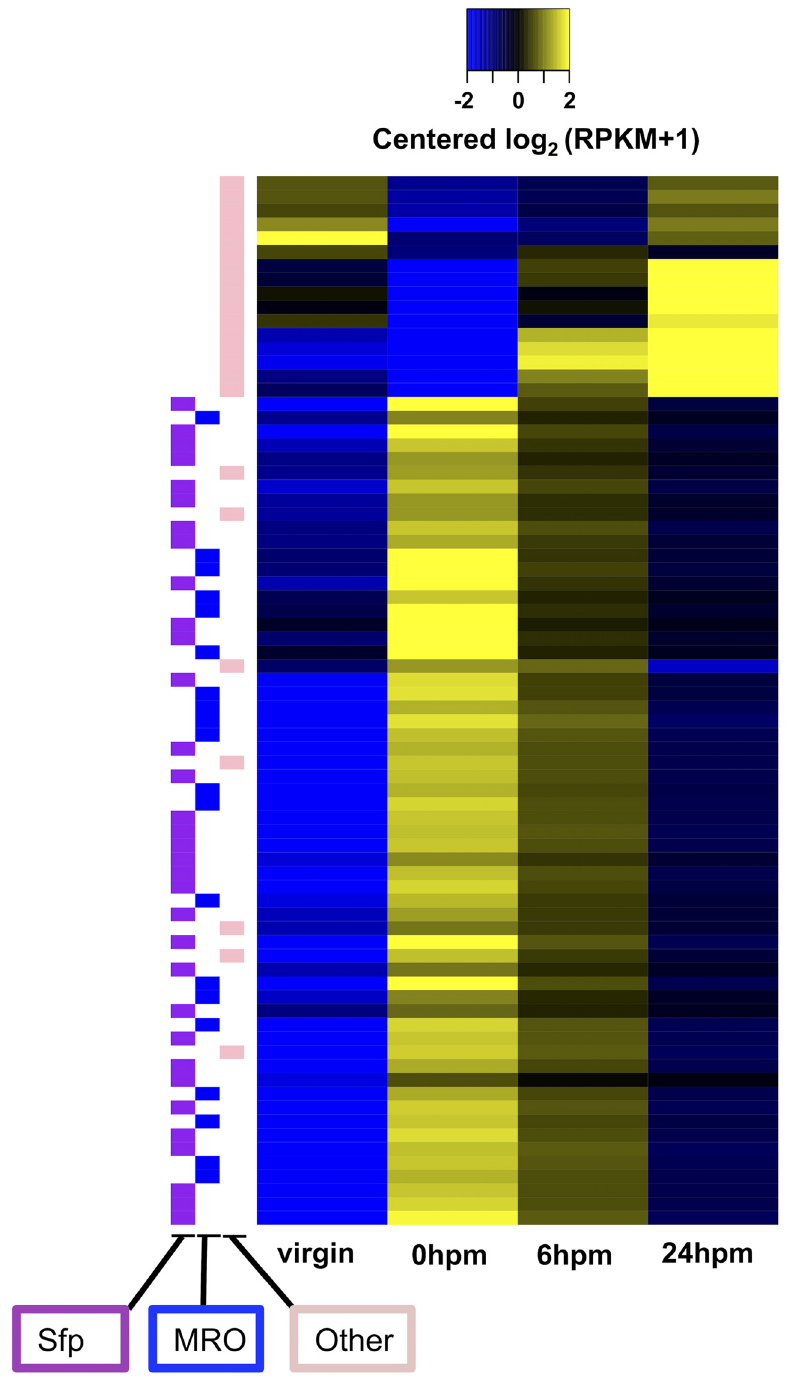
Fig 3. Expression profile of transcripts that are differentially expressed between the virgin and 0hpm sample, including their behaviors at 6 and 24hpm. The color scale represents the median-centered log2 RPKM values. Each row is a transcript and the samples are indicated at the bottom (ordered chronologically from left to right). The top 16 transcripts represent the down-regulated set, while the remaining 60 are those with higher abundances at 0hpm relative to virgin. Transcripts found to be up-regulated in male reproductive organs (MRO)[29], as well as known Sfp genes (Sfp)[39], are indicated on the left by blue (n = 20) and purple markers (n = 33),